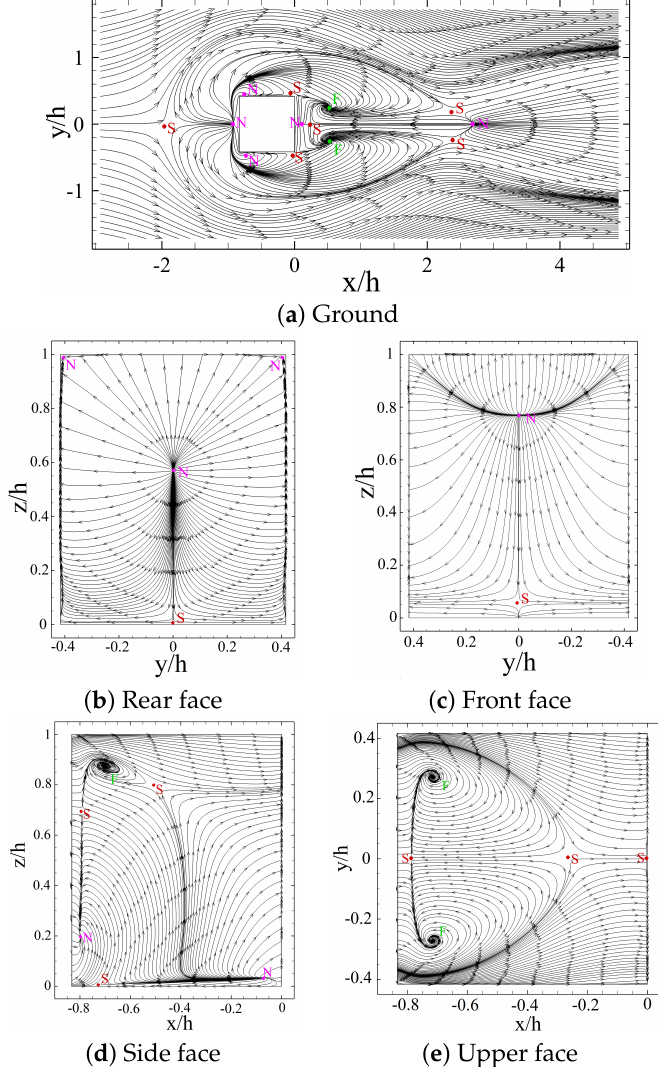
Figure 11. Critical points on the faces of the square prism. The iso-surface of the Q -criterion, normalized using the prism height ( h ) and freestream velocity ( U ∞ ) and denoted by Q ∗ , are shown in Figures 12 and 13 from two perspectives: the front and rear views of the prism. The plots in Figure 13 identify that the